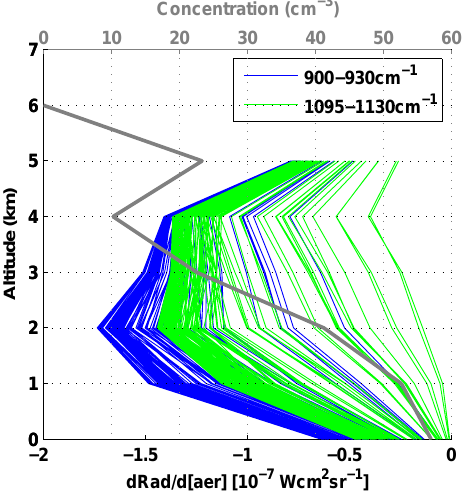
Fig. 5. Radiance derivatives with respect to aerosol amount in each layer for one specific case corresponding to the first aerosol vertical profile shown in Fig. 10. The jacobians were plotted in a different color for the two retrieval windows defined in Sect. 4.3, and the retrieved vertical profile of aerosols is plotted in grey (top x